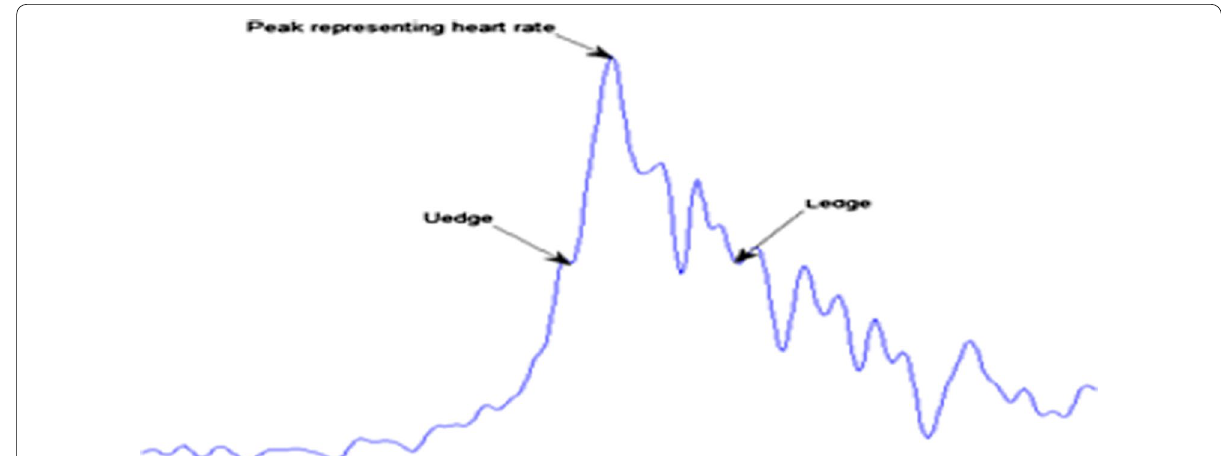
Fig. 6 Fundamental frequency and 3db points on FFT signal: Fundamental frequency in this figure represents the average heart rate of the signal where most of the information is preserved in fundamental frequency and standard 3db points have taken on either side of fundamental frequency peak to find out the wobbling of the heart